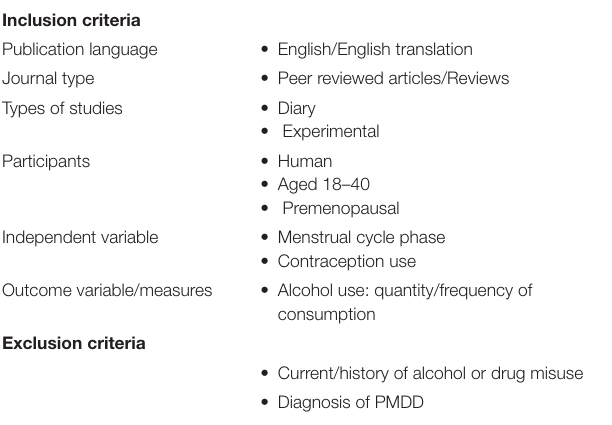
TABLE 1 | Screening